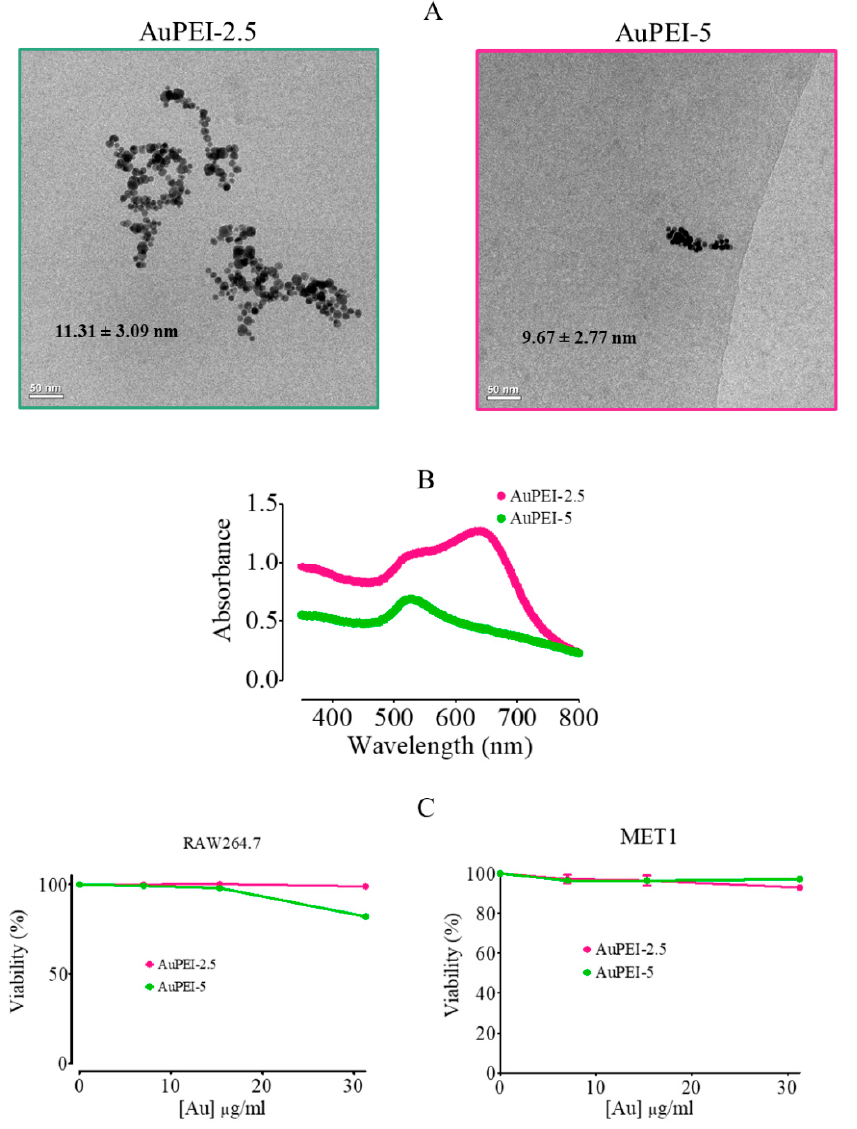
Figure 1. AuPEI nanocomposite characterization and toxicity. ( A ) Cryo-TEM imaging of AuPEI nanocomposites at 30 days. ( B ) One-year-old AuPEI nanocomposite absorbance profile showing the primary and secondary plasmon resonance band. ( C ) Viability of RAW264.7 and MET-1 cell lines after incubation with different concentrations of AuPEI nanocomposites.